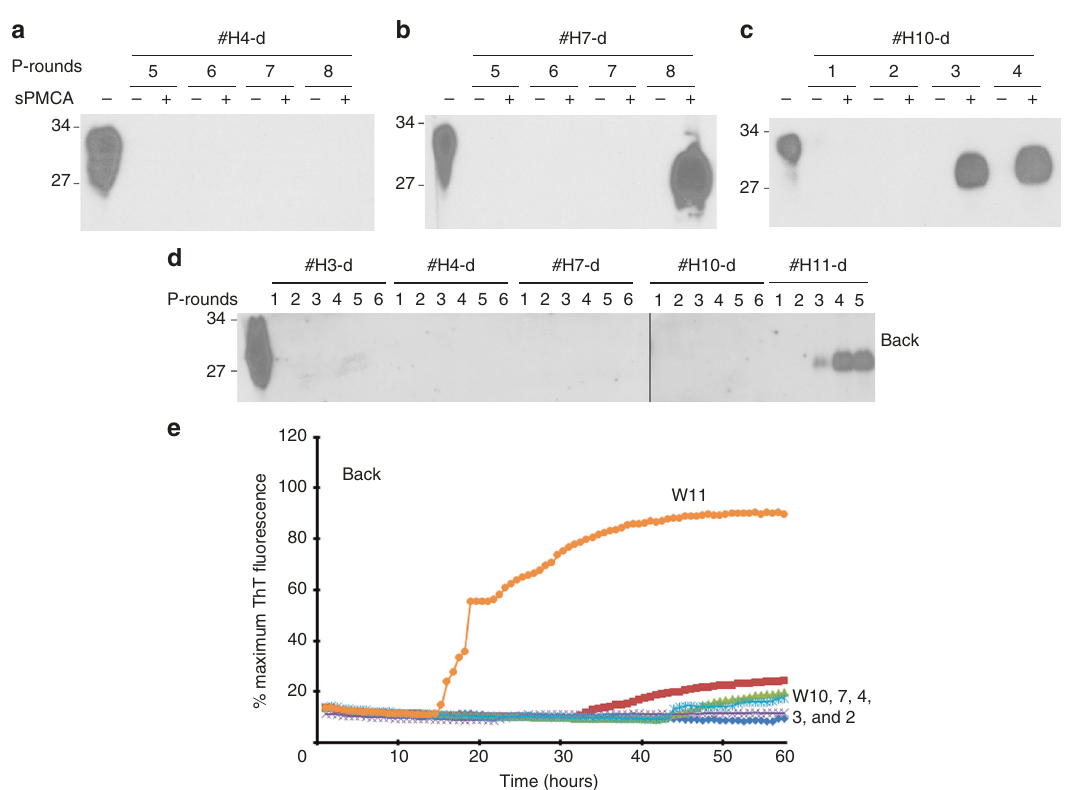
Fig. 7 PrP Sc in PBS-inoculated hamsters co-habitated with 263K-inoculated hamsters. Representative western blotting of PrP Sc ampli fi ed by sPMCA with brain homogenates from PBS-inoculated hamsters in cohabitation with 263K-inoculated hamsters killed at 4 a , 7 b , 10 c wpi from three-independent experiments. d Representative western blot analysis of PrP Sc ampli fi ed by six rounds of sPMCA from back skin samples from the PBS-inoculated with PBS killed after 3, 4, 7, 10, and 11 weeks of cohabitation with 263K-inoculated hamsters from three-independent experiments. P-rounds: number of sPMCA rounds. All samples were treated with PK at 100 µ g/ml except for the sample in the fi rst lane of each blot that was used as a non-PK treatment control. The molecular weight markers are shown in kDa on the left side of each blot. All blots were probed with the 3F4 antibody. e Representative of RT-QuIC trace of back skin samples from PBS-inoculated hamsters co-habitated with the 263K-inoculated mice at different time